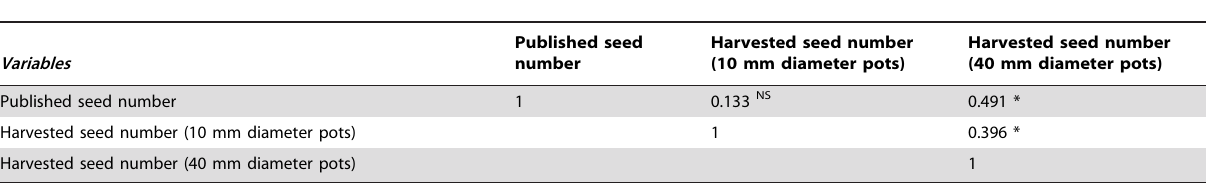
Table 2. Correlations (* P , 0.05, NS non significant, n =30) between the mean seed number recorded for each line in a previously published study (Alonso-Blanco et al., 1999) and the mean seed number produced by plants in the experiment reported here (harvested seed number) in two pot